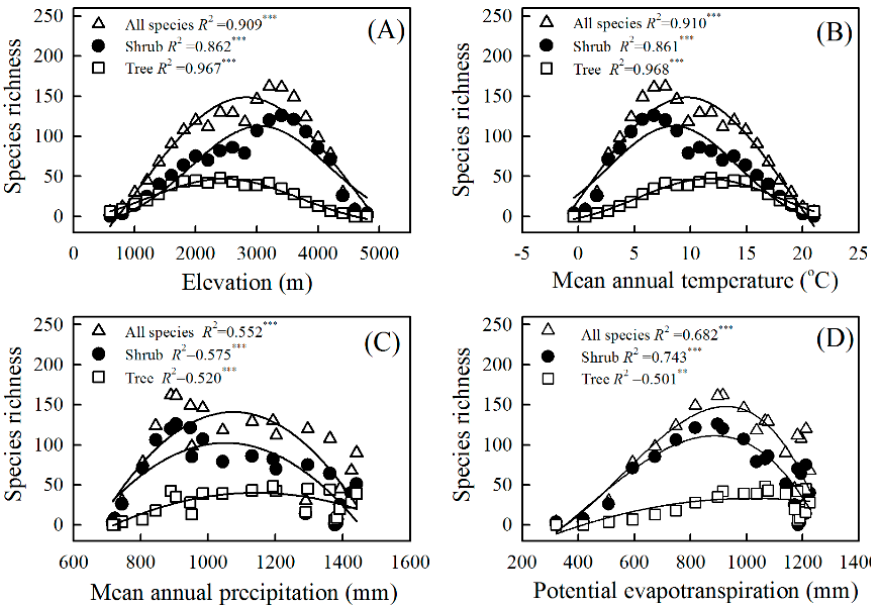
Figure 3. Variations in species richness within Ericaceae for all species, trees, and shrubs as function of elevation ( A ), mean annual temperature ( B ), mean annual precipitation ( C ), and potential evapotranspiration ( D ) in Yunnan Province, China. The explanatory powers ( R 2 ) were evaluated by polynomial models. ** p < 0.01; *** p < 0.001.